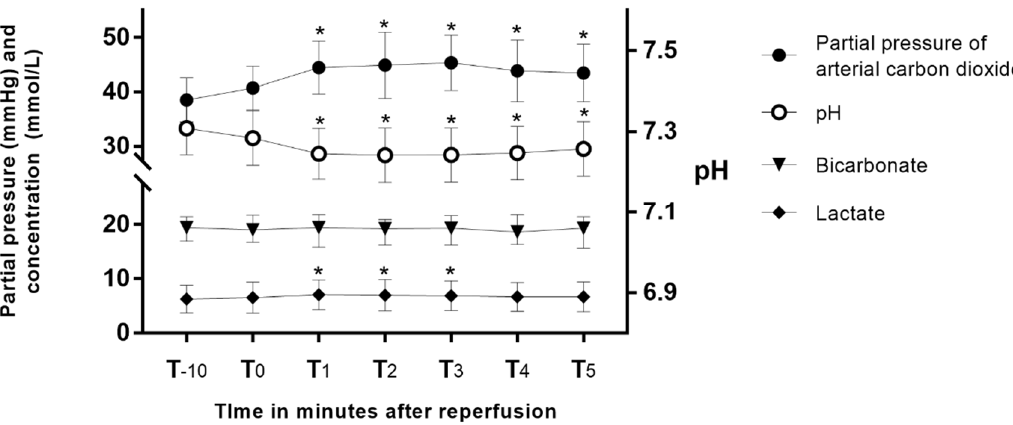
Figure 2. Changes in partial pressure of arterial carbon dioxide, pH, bicarbonate, and lactate after reperfusion. *: p < 0.05 versus T 0 .